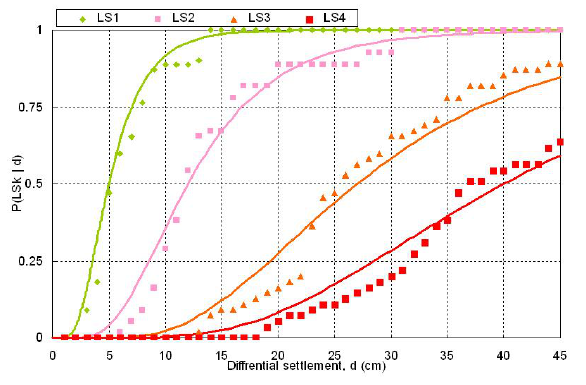
Fig. 9. Fragility curves obtained for a one bay-one storey encasing RC frame building, considering 4 damage limit states: Slight (LS1), Moderate (LS2), Extensive (LS3) and Complete (LS4).